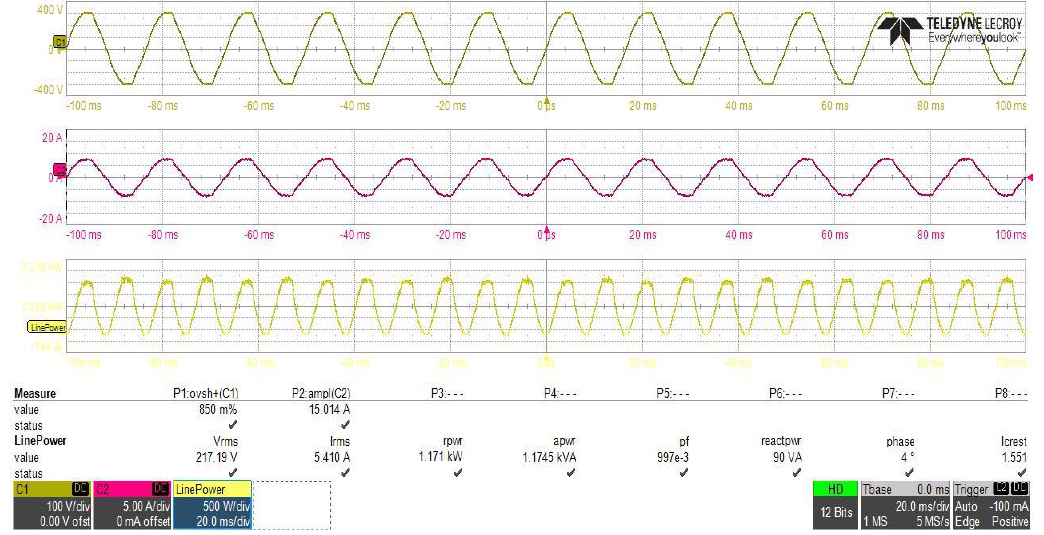
Figure 25. PFC converter stage power analysis with using of the proposed inrush current mitigation Figure circuit.